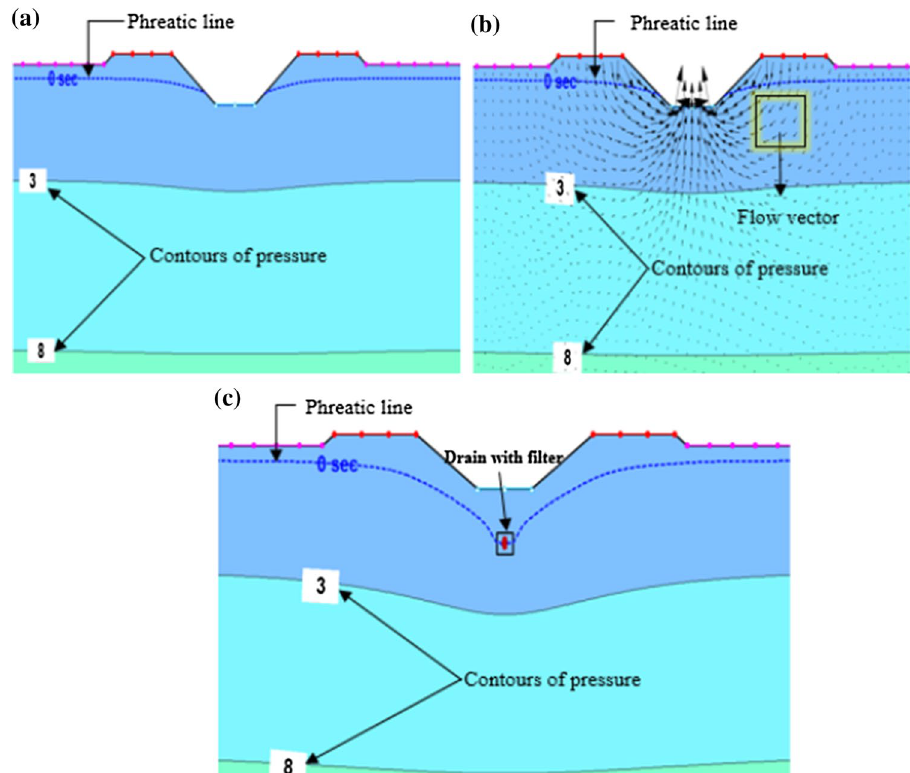
Fig. 5 a Seepage lines without a drain and filter with H = 20.8 m, b flow vectors for a canal with- out a drain and filter H = 20.8 m, c seepage lines with a drain and filter for H = 20.8 m, Y = 21.5 m, D = 0.2 m and t = 0.25